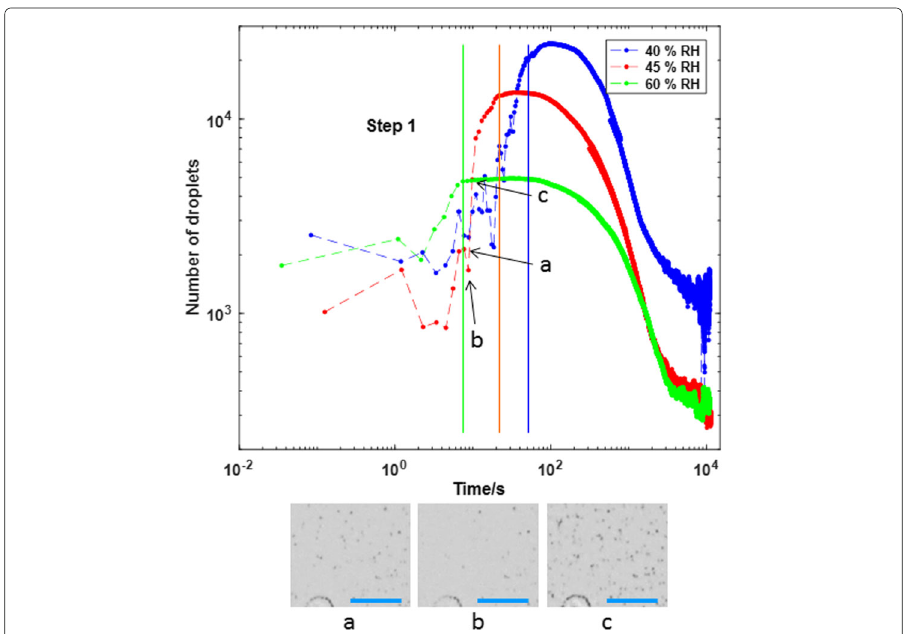
Fig. 6 Number of droplets as a function of time for the 40%, 45% and 60% relative humidity. Pictures ( a ), ( b ) and ( c ) represent evaporation and re-condensation event during the droplet appearance step for the 45% relative humidity. The scale bar corresponds to 160 μ